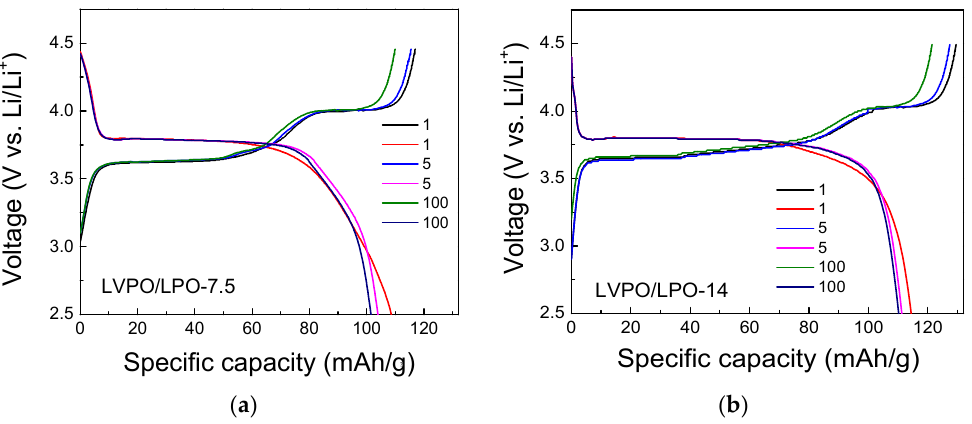
Figure 6. Electrochemical voltage profiles for ( a ) Li 3 V 2 (PO 4 ) 3 (92.5 wt%)/Li 3 PO 4 (7.5wt%), ( b )